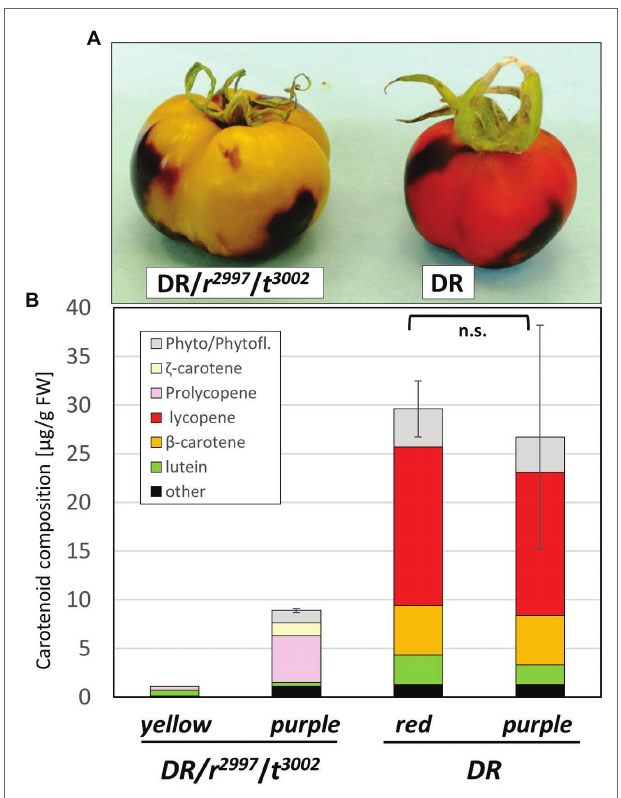
while the expression of PSY1 was unchanged ( Figure 7 ). The elimination of carotenoid synthesis by PSY2 silencing in the DR / r 2997 / t 3002 line confirms that carotenoid biosynthesis recovery in the double mutant r 2997 / t 3002 depends on PSY2 activity.